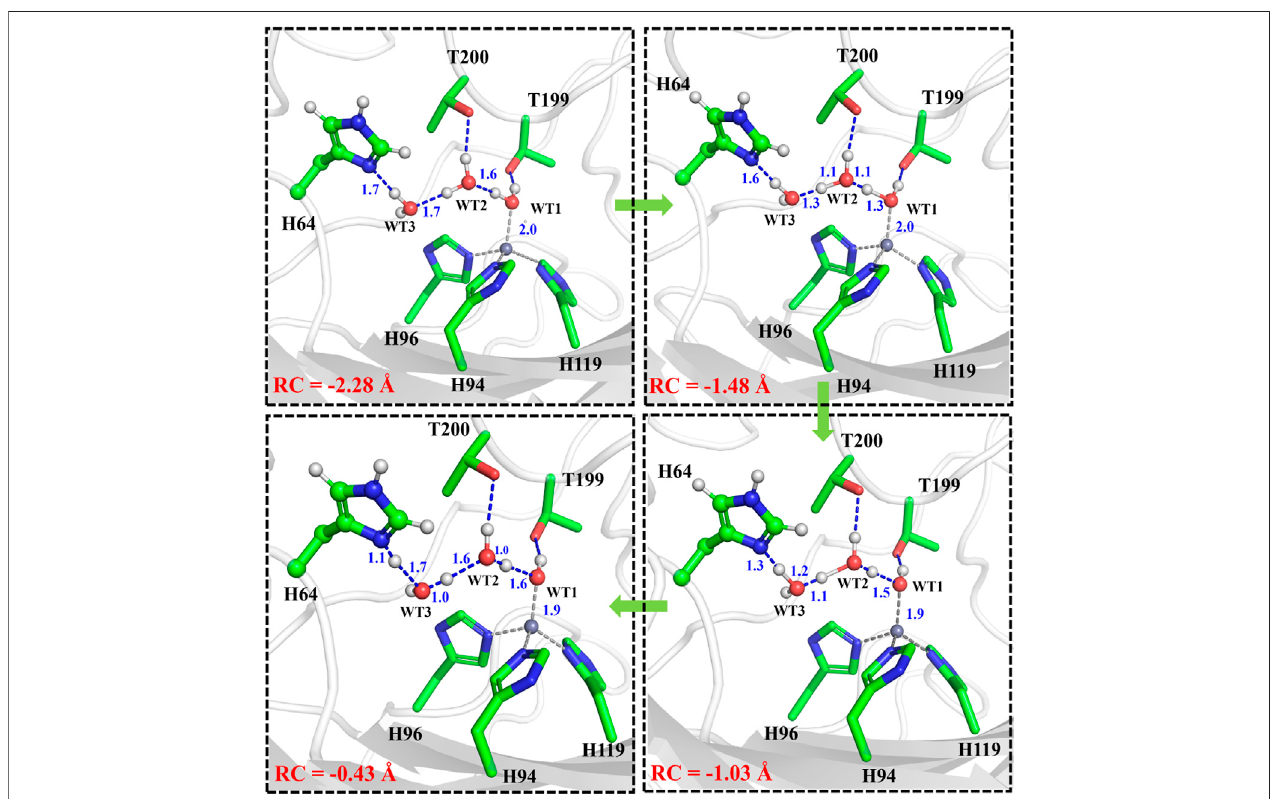
FIGURE 6 | Representative structures of the active site during the proton transfer between WT1 and the residue H64.